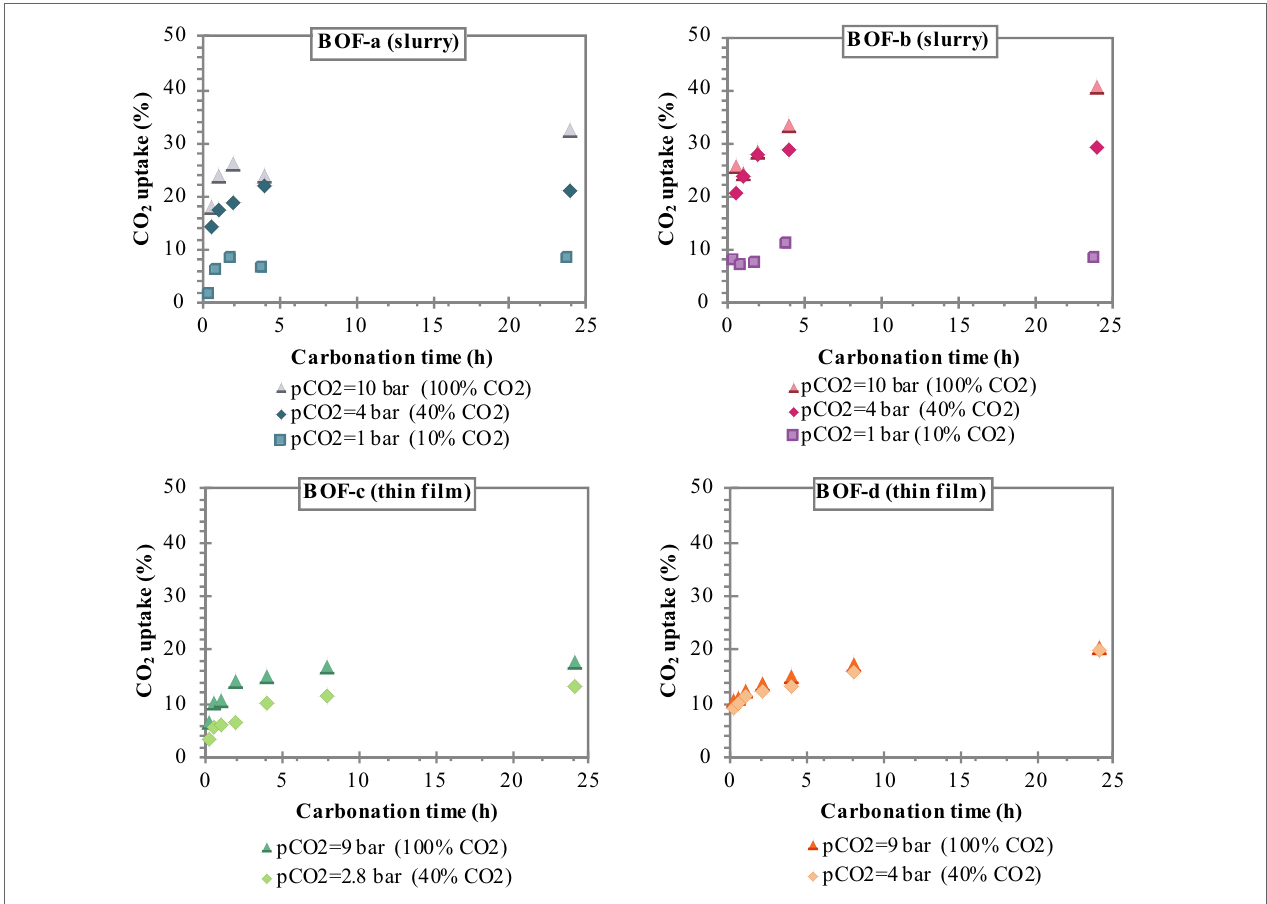
FigUre 2 | cO 2 uptake attained for the slurry-phase route with BOF-a and BOF-b samples ( T = 100°c) and the thin-film route with BOF-c samples and BOF-d samples ( T = 50°c)